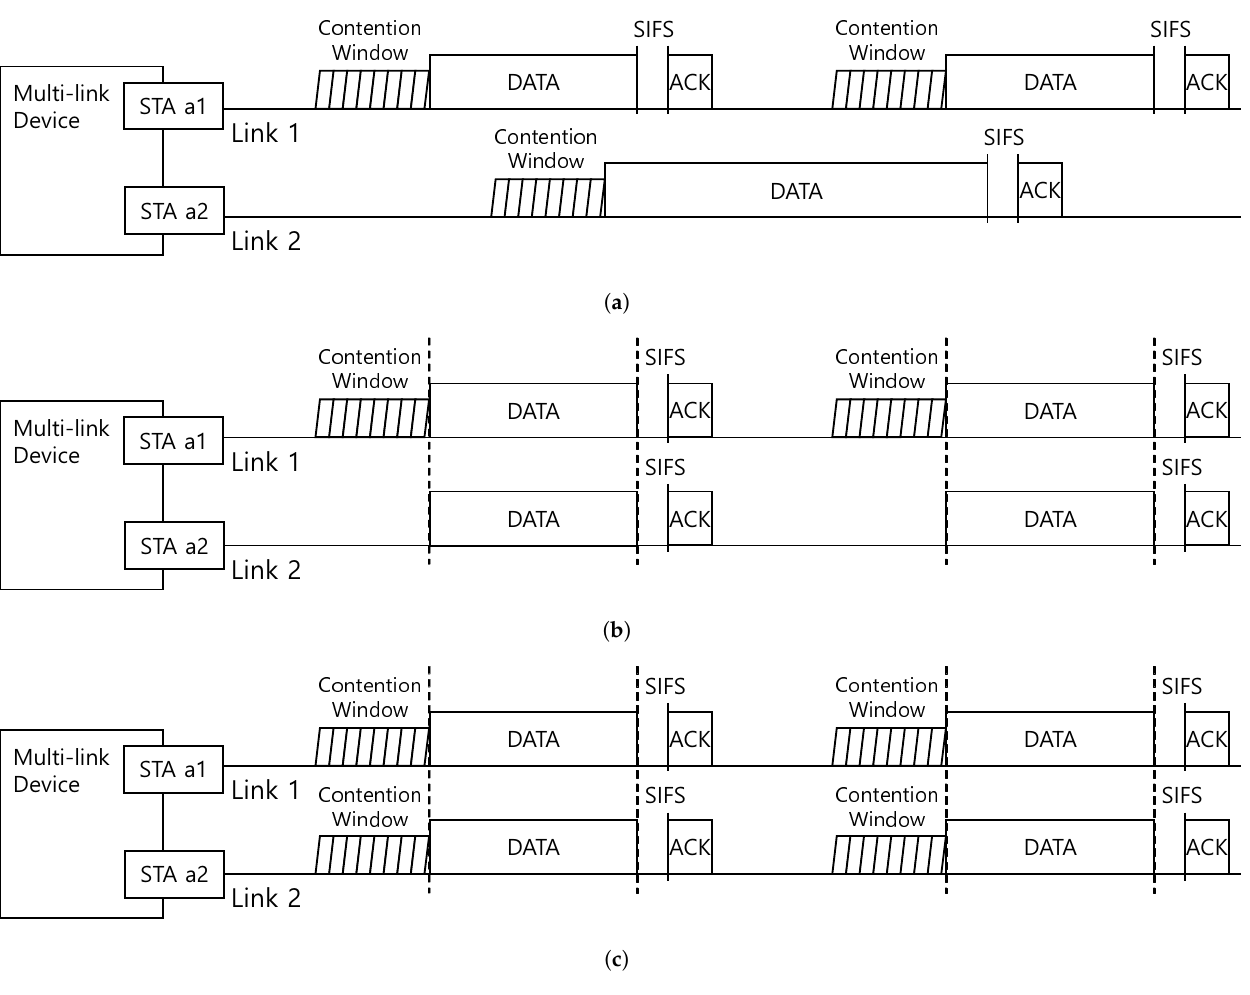
Figure 3. Illustrative examples of multi-link transmission. ( a ) Asynchronous multi-link transmission, ( b ) synchronous multi- link transmission with a single accessing link, and ( c ) synchronous multi-link transmission with multiple accessing